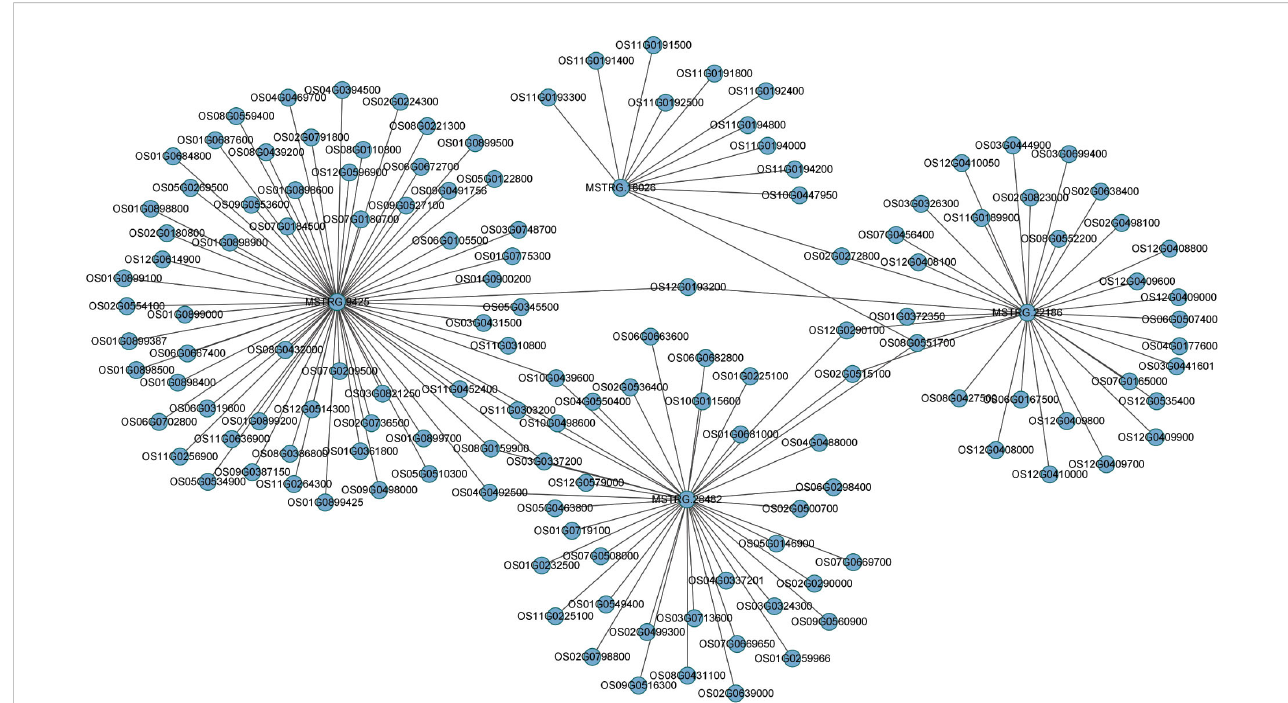
FIGURE 6 Predicted interaction network of expressed lncRNAs and PCGs. Expressed lncRNAs are depicted in the center targeting their counterpart coding genes expressed in the study after BPH